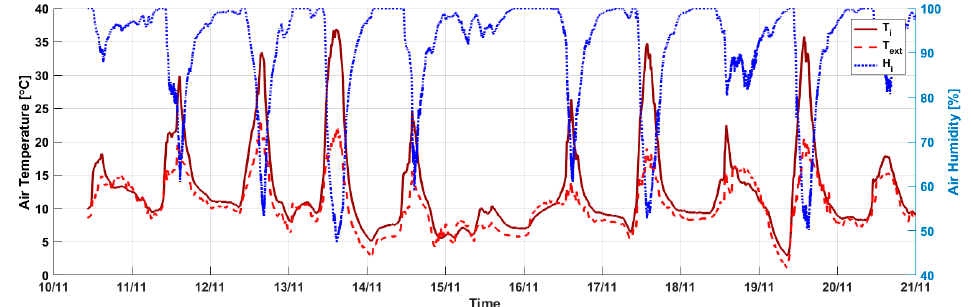
Figure 29. Recorded dataset ( T i , H i -indoor air temperature / relative humidity, T ext -outdoor air temperature) [66].